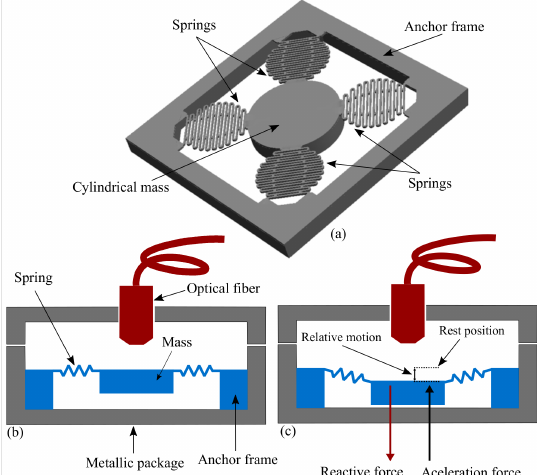
Figure 1. Graphical representation of ( a ) the MEMS device, ( b ) metallic package coupling the MEMS structure with an optical fiber, and ( c ) the sensor’s reaction to exerted acceleration.